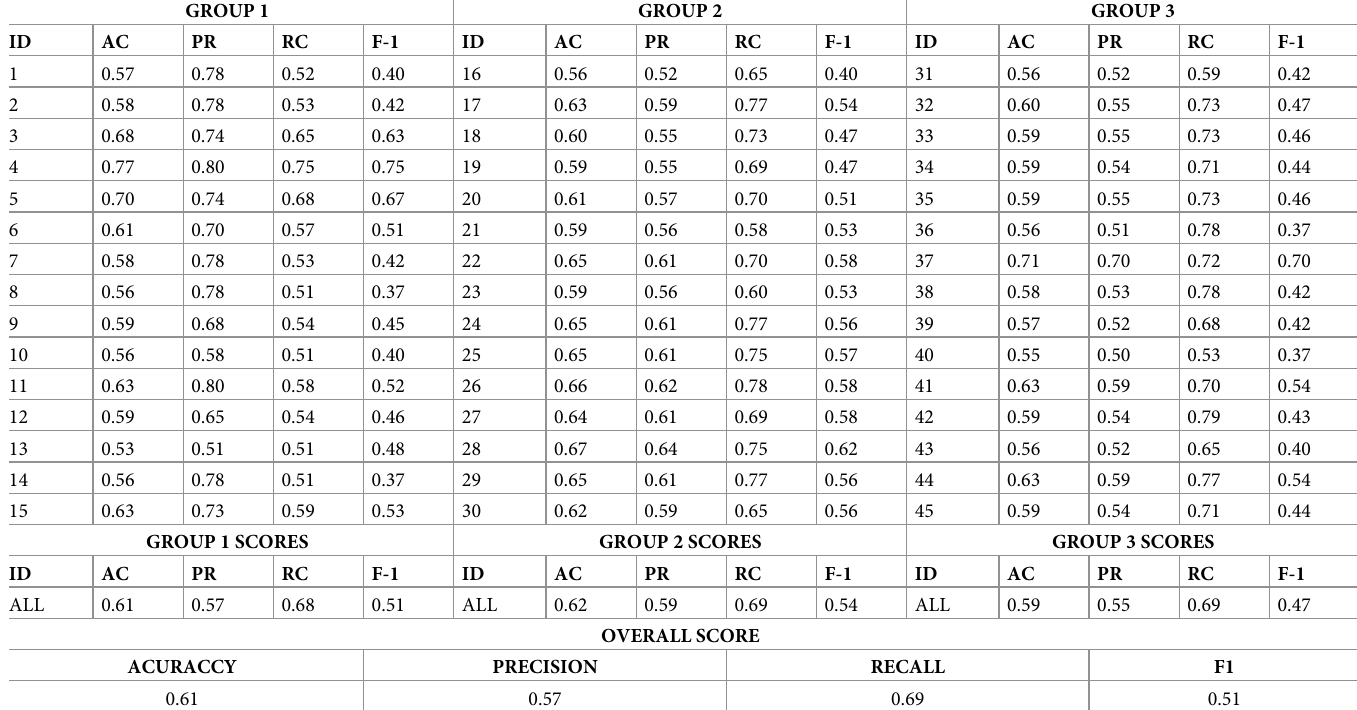
Table 6. Result metrics for both groups in Task 1 where ID = User Id, AC = Acuraccy, PR = Precision and Group 1: older people, Group 2: people with intellectual disabilities and Group 3: control users. GROUP 1 GROUP 2 GROUP